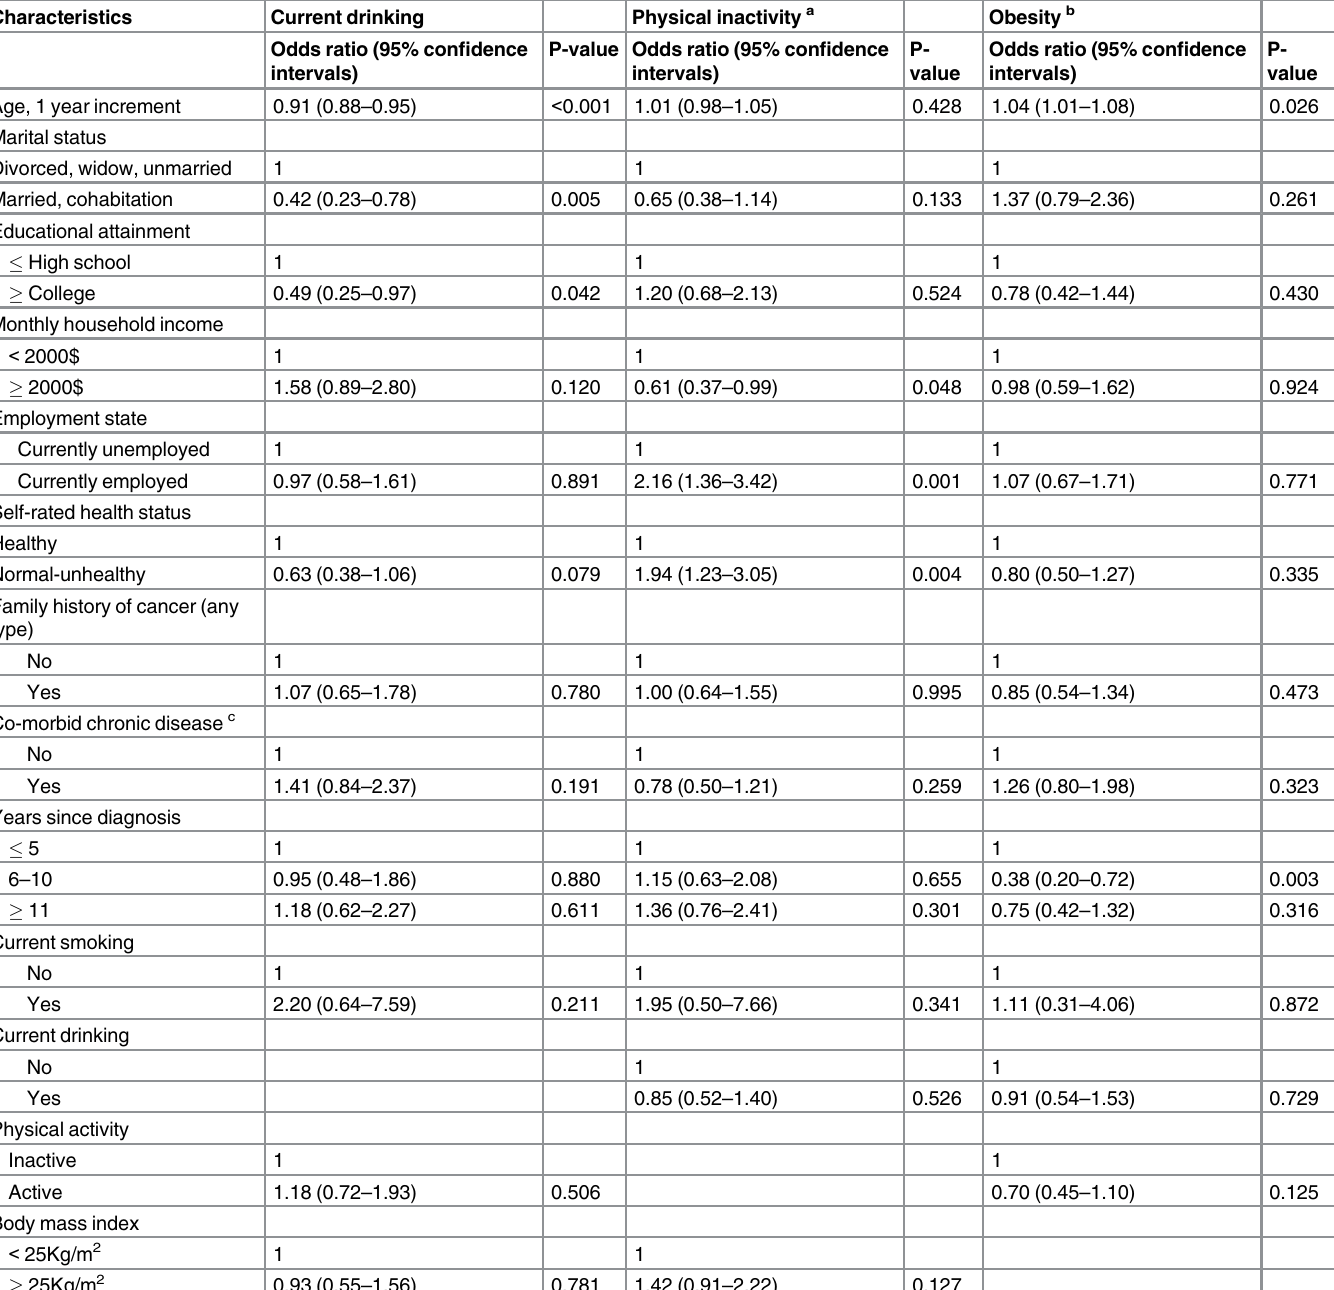
Table 3. Adjusted odds Ratio of health behaviors for each sociodemographic characteristic among the survivors of cervical